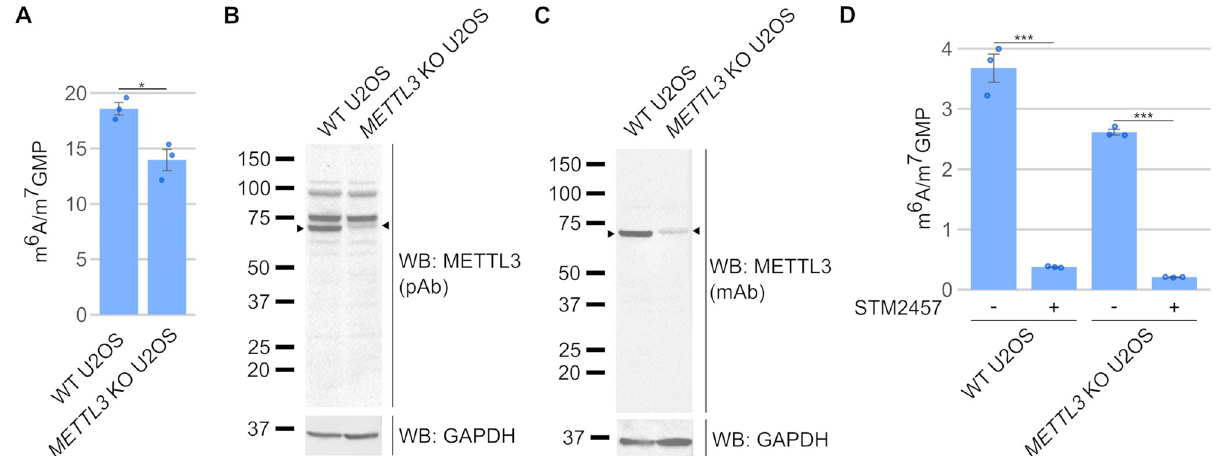
Fig 3. METTL3 knockout in U2OS cells also appears to be incomplete. ( A ) METTL3 KO U2OS cells have persistent m 6 A. METTL3 KO U2OS cells have been reported to have 60% the levels of m 6 A found in control U2OS cells [24]. We reconfirmed this with mass spectrometry measurements of m 6 A, which showed that METTL3 KO U2OS cells have 75.2% remaining m 6 A compared to WT. Thus, m 6 A levels remain high in METTL3 KO U2OS cells. Error bars indicate standard error ( n = 3). � = p -value < 0.5, �� = p -value < 0.01, ��� = p -value < 0.005, n.s. = not significant. Underlying data can be found in S1 Data. ( B ) METTL3 KO U2OS cells express a novel anti-METTL3-antibody-reactive protein. As m 6 A levels were not completely ablated in the METTL3 KO U2OS cells, we assessed METTL3 protein expression in these cells to confirm if the knockout was effective. We found that WT METTL3 protein was lost in the METTL3 KO U2OS cells, but a larger protein that was reactive to the anti-METTL3 antibody was found in the METTL3 KO U2OS cells. This suggests the METTL3 KO U2OS cells express a novel METTL3 protein that is slightly larger than the WT METTL3. ( C ) Confirmation of a novel METTL3-like protein in METTL3 KO U2OS using a second METTL3 antibody. To confirm that the METTL3-immunoreactive band we saw in METTL3 KO U2OS cells in Fig 3B was METTL3, we used a second anti-METTL3 mAb to confirm the result. The same protein band is immunoreactive to the second anti-METTL3 antibody, thus suggesting that the METTL3 KO U2OS cells express a novel, larger METTL3 protein. ( D ) A METTL3-specific inhibitor leads to loss of m 6 A even in METTL3 KO U2OS cells. WT and METTL3 KO U2OS cells were treated with 30 μ M STM2457, and m 6 A levels were measured by mass spectrometry after 48 h. m 6 A was reduced by 89.8% in the WT U2OS cells and 92.1% in the METTL3 KO U2OS cells after STM2457 treatment. It should be noted that 30 μ M may not fully inhibit METTL3, so some of the residual m 6 A after STM2457 treatment may still derive from METTL3 isoforms. Thus, a METTL3 isoform is responsible for most of the remaining m 6 A in the METTL3 KO U2OS cells. Error bars indicate standard error ( n = 3). � = p -value < 0.5, �� = p -value < 0.01, ��� = p -value < 0.005, n.s. = not significant. Underlying data can be found in S1 Data. mAb, monoclonal antibody; m 6 A, N 6 -methyladenosine; pAb, polyclonal antibody; WB, western blot; WT,